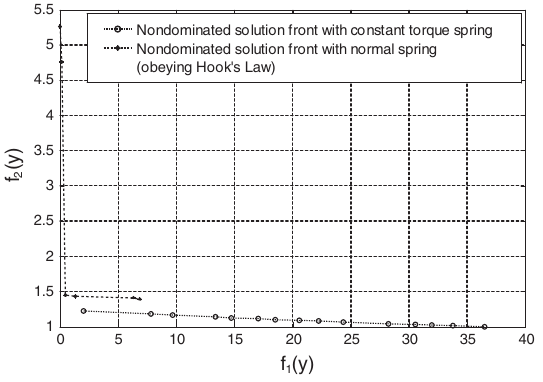
Fig. 11. Pareto-optimal solution sets with conventional spring and constant-torque